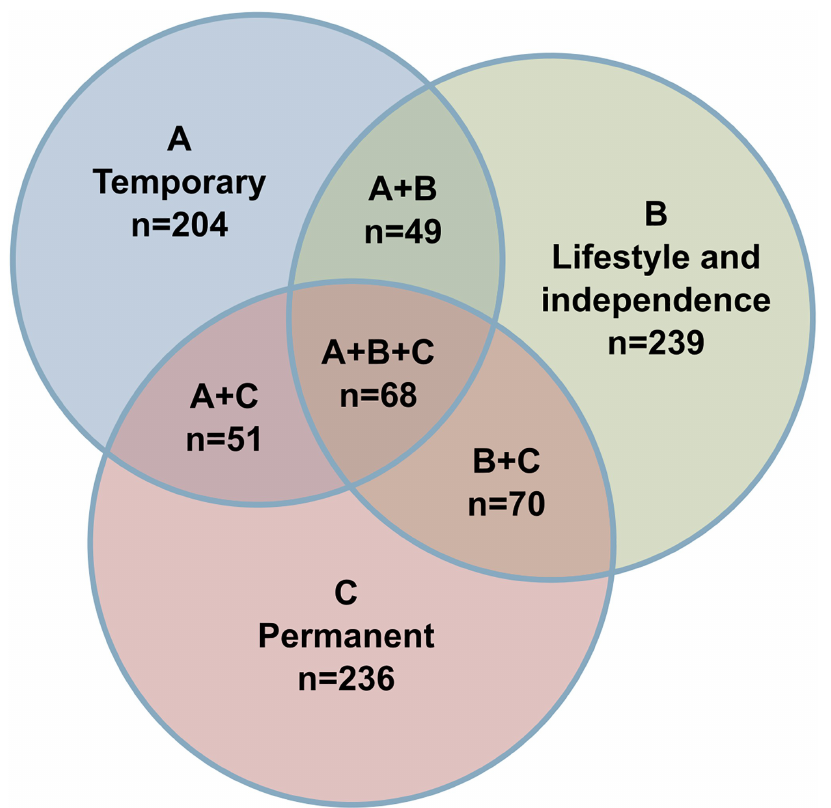
Fig 1. Number of patients with EWA in different risk factor categories. (A) Temporary risk factors = Antibioticor antifungaltherapy, Recent medicaltreatment (Hospitalization or outpatient visit in the preceding1 month) or Chemotherapy; (B) Lifestyle and independence related risk factors = Alcohol abuse, Active smoking or non-independencein everydayliving; (C) Permanent risk factors = Severe renal dysfunction (eGFR < 30), Mechanical heart valve prosthesis, Active malignancyor Chronic heart failure.